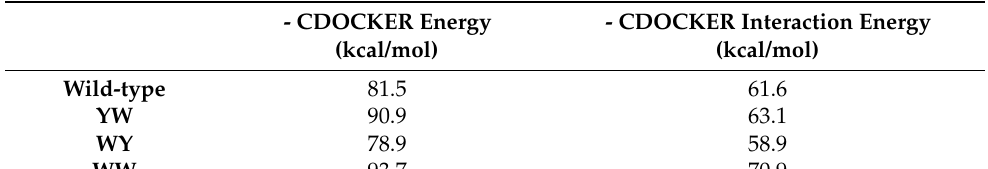
Table 4. -CDOCKER Energy and -CDOCKER Interaction Energy calculated by CDOCKER in Discov- ery Studio for each mutant.